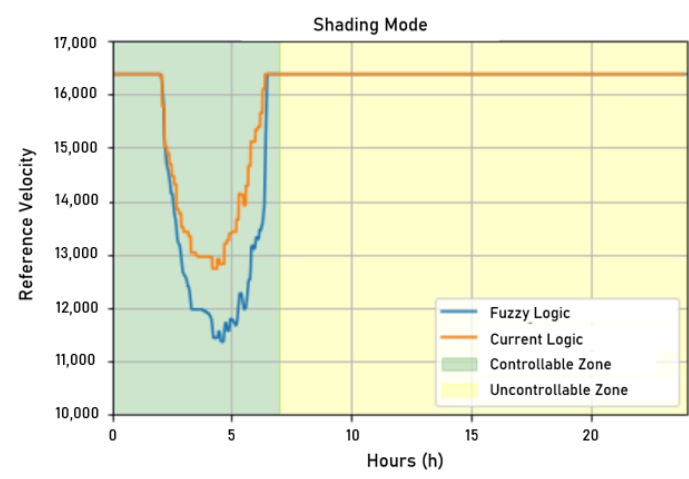
Figure 26. Shading test for fuzzy control. Source: